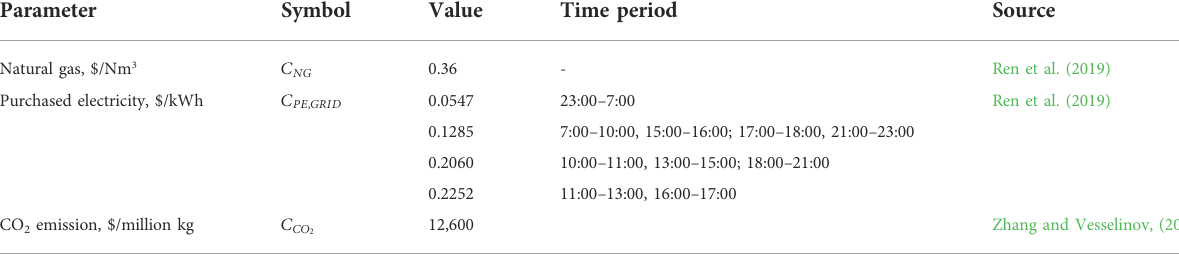
TABLE 3 Unit price of electricity from the grid, natural gas, and CO 2 emission.